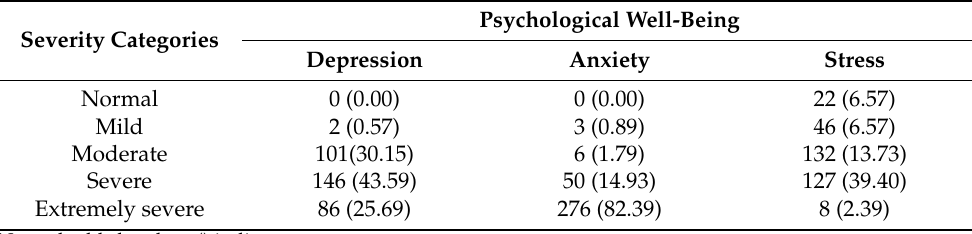
Table 4. The results of the severity level of psychological well-being (depression, anxiety and stress). Severity Categories